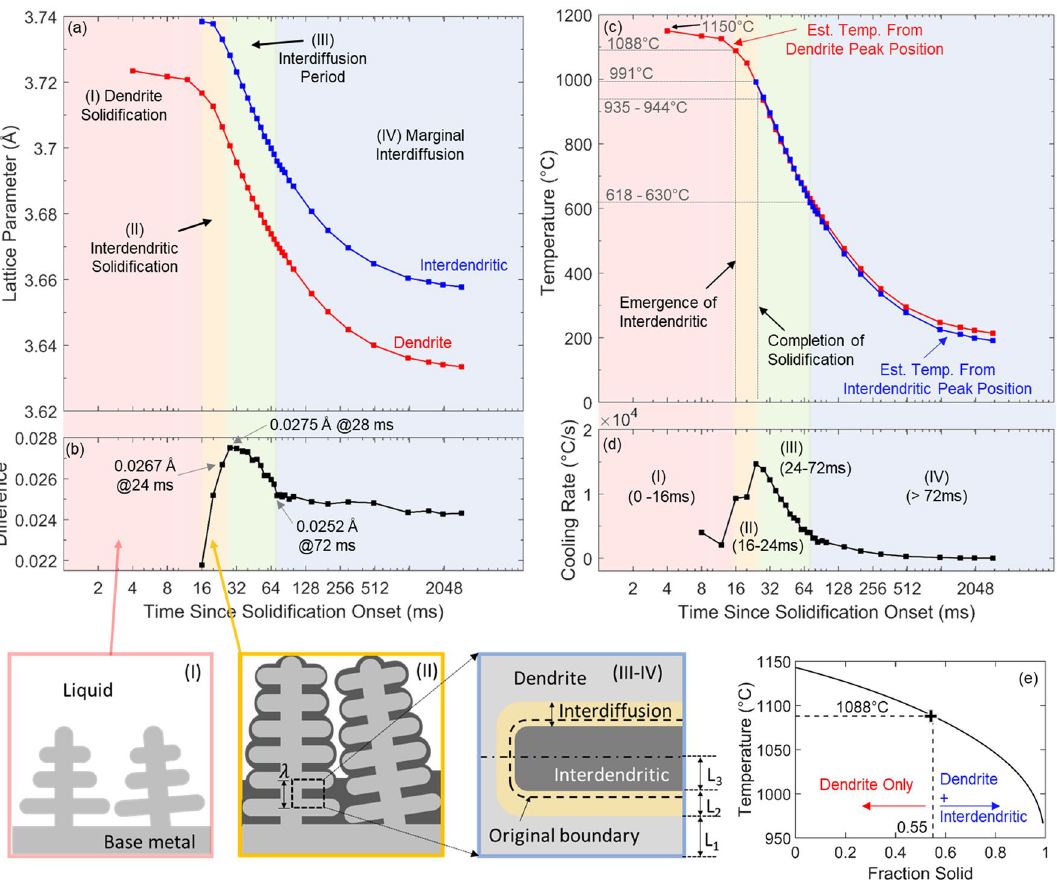
Figure 4. Solidification behavior analysis from experimental (200) XRD data: ( a ) Time-evolution of FCC lattice parameters corresponding to the dendritic and inter-dendritic peaks, determined from Pearson VII functions fit to the data; ( b ) Time-evolution of the lattice parameter difference between the dendritic and inter-dendritic regions; ( c ) Temperature profiles estimated based on lattice parameter evolution and using the variable CTE data collected through dilatometry; ( d ) The instantaneous cooling rate calculated from the temperature profile; and ( e ) Scheil solidification curve indicating the fraction of solidifying material partitioning to the dendritic and inter-dendritic regions, based on the temperature at the termination of Stage I. Schematics illustrate the dendritic microstructure evolution of the MPCA at each stage of solidification and